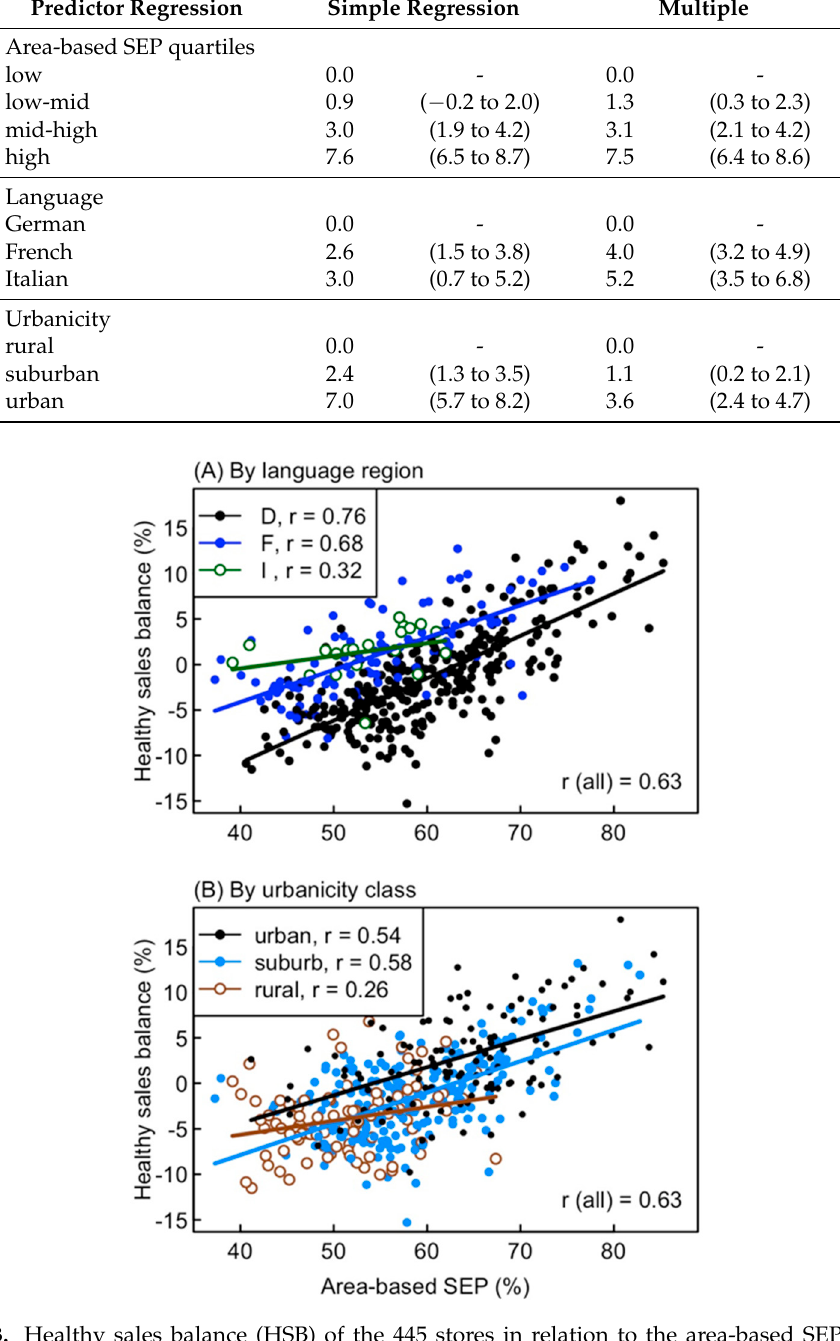
Figure 3. Healthy sales balance (HSB) of the 445 stores in relation to the area-based SEP ( A ) by language region (D = German, F = French, I = Italian) and ( B ) by urbanicity class. Pearson correlation coefficients and ordinary regression lines are given for each subset of stores, and correlation coefficients are also given for all stores together. HSB is the difference between healthy and unhealthy sales as the percentage of total food sales. Confidence intervals for correlation coefficients are given in Table S1.